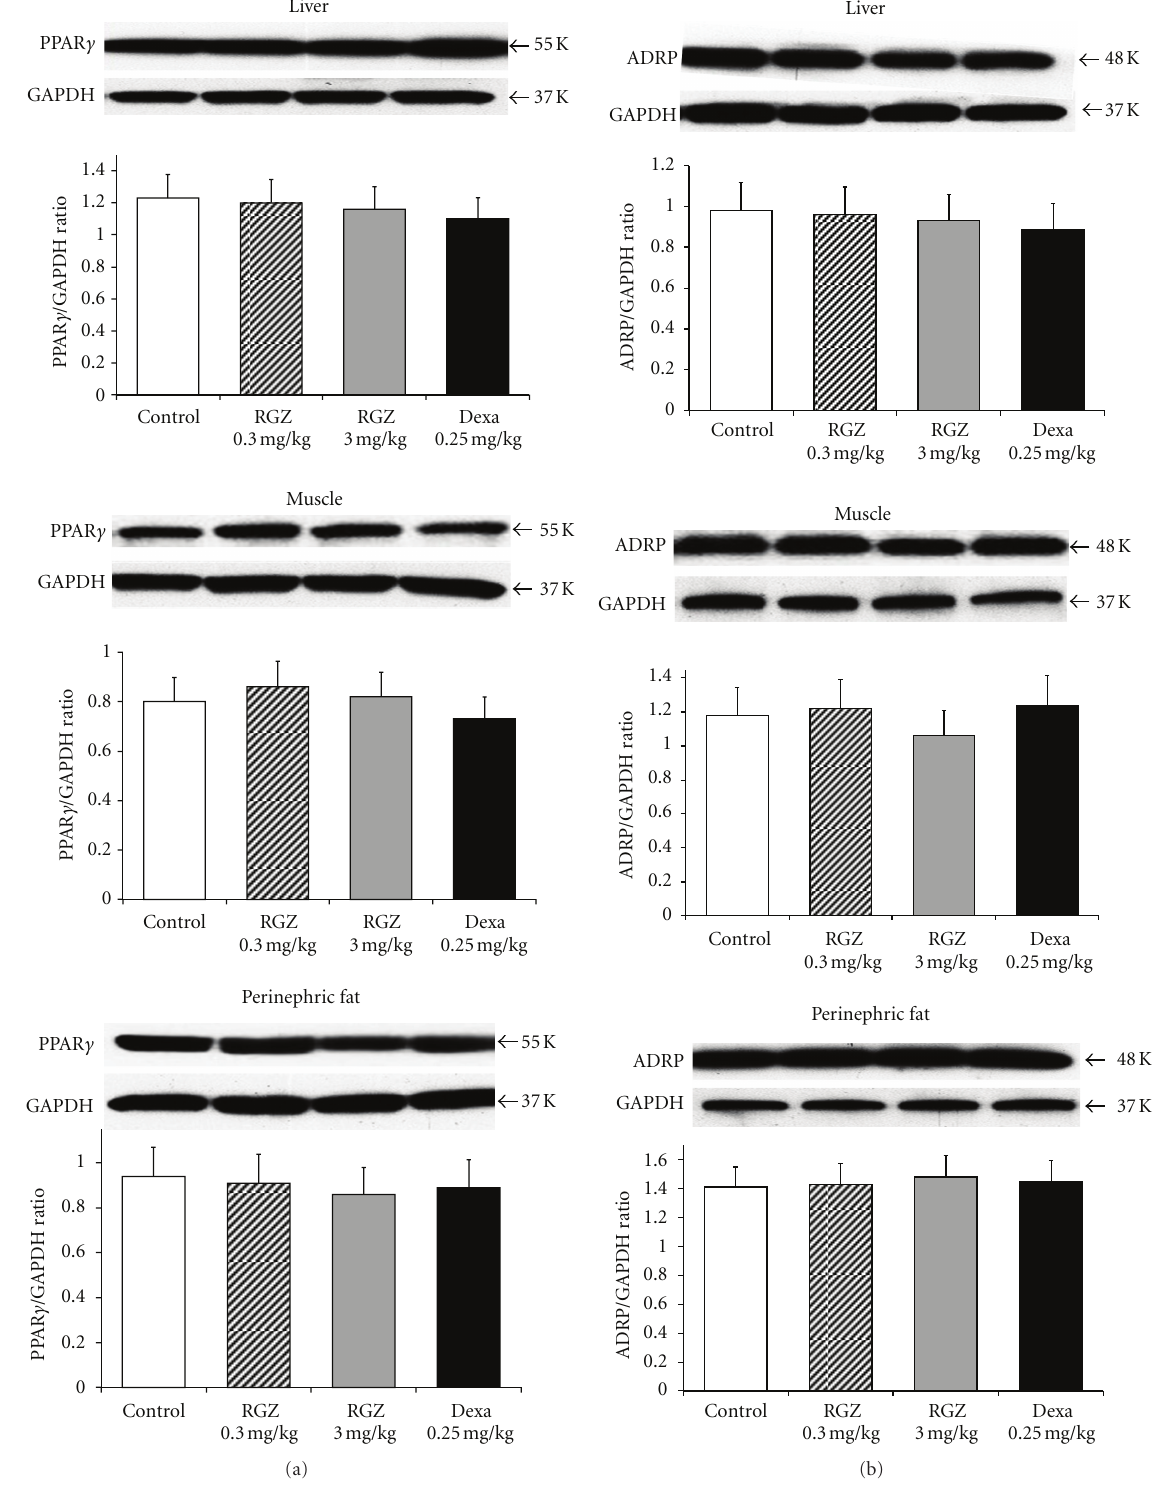
Figure 5: E ff ect of RGZ on PPAR γ and ADRP expression in liver, skeletal muscle, and perinephric fat. Utilizing Western blot assay, PPAR γ (a) and ADRP (b) protein levels were examined in the whole tissue lysates of liver, skeletal muscle, and perinephric fat. There were no significant di ff erences ( P > 0 . 05) in the protein levels of PPAR γ and ADRP in the liver, skeletal muscle, or perinephric fat, normalized to GAPDH, in the treated groups compared with the control. Representative Western blots and the corresponding density histograms are shown ( n = 4 in each